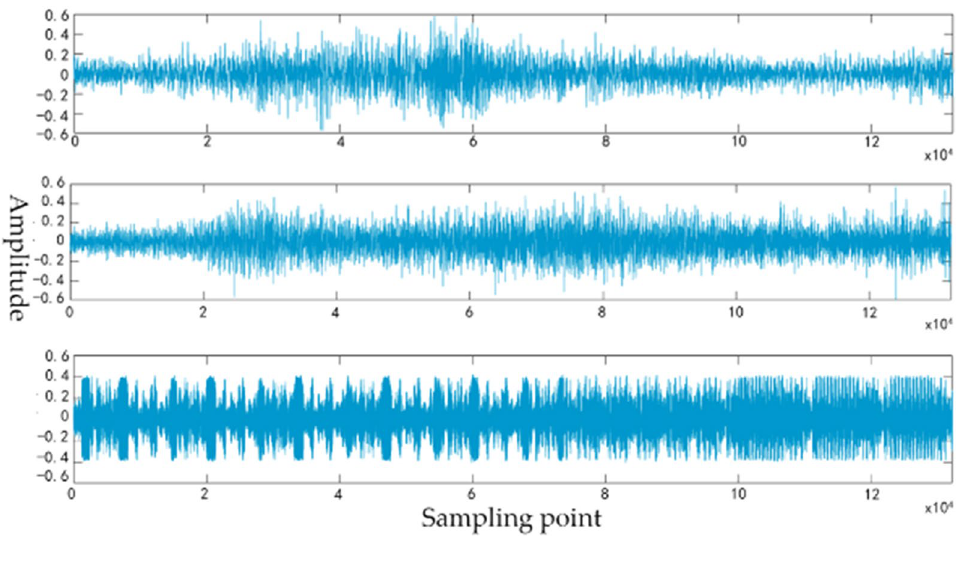
Figure 8. The vehicle audio waveform.